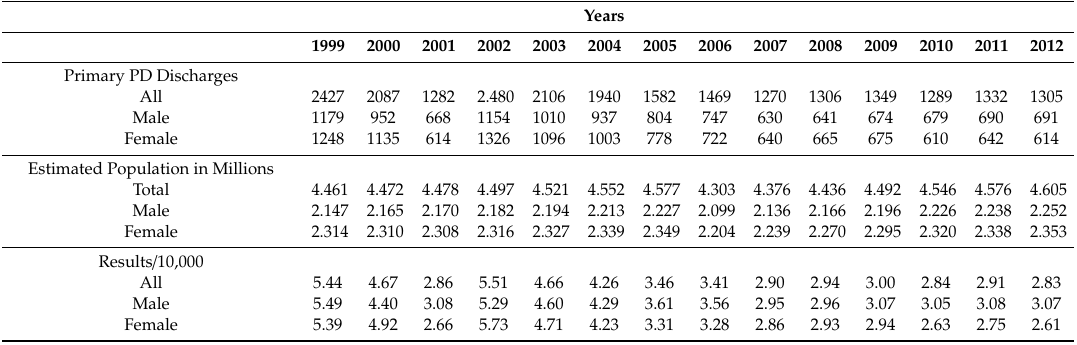
Table 1. Louisiana hospital primary discharge diagnoses of Parkinson’s disease,